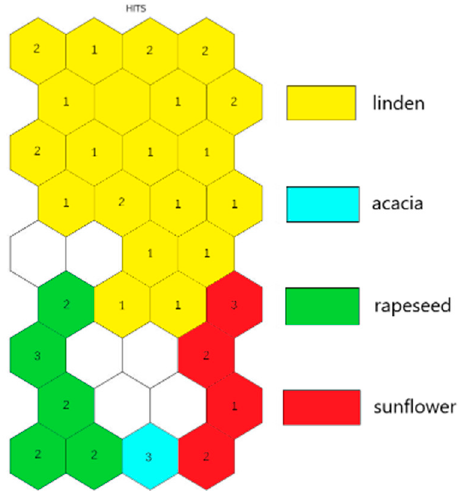
Figure 1. The HIT diagram of training set with all variables.